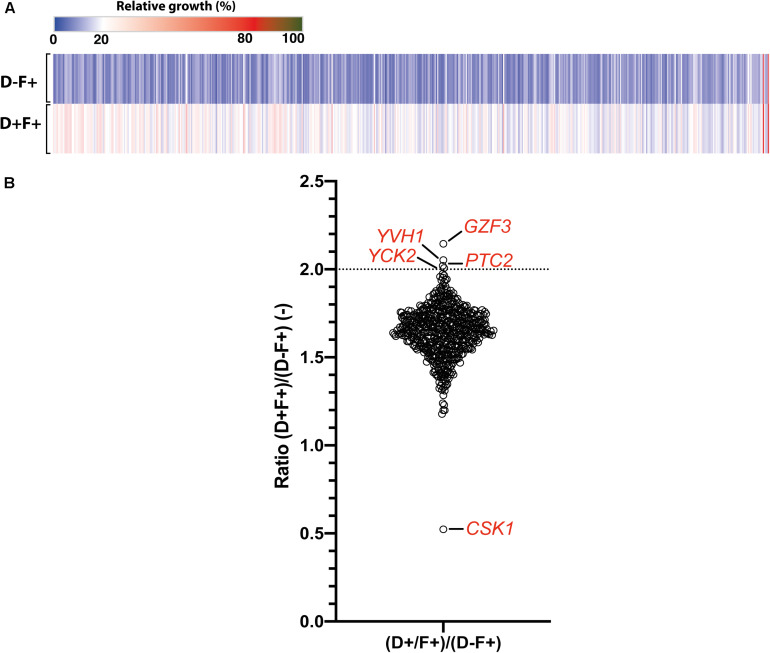
Single strain tolerance profiling. (A) Heatmap representing the relative growth of the 572 Tet-inducible OE BC strains collection at pH 6, in presence of 32 μg/ml FLC pressure (F+) and in presence (D+) or absence (D–) of 100 μg/ml Dox. Each line represents the mean relative growth of biological triplicates. (B) Effect of Dox induction upon FLC tolerance represented as the growth ratio between the condition with and without Dox [(D+F+)/(D–F+)]. Specific genes above a ratio of 2-fold relative growth increase (dotted line) and below a ration of 1.0 are indicated. Detailed data can be found in Supplementary File S2.